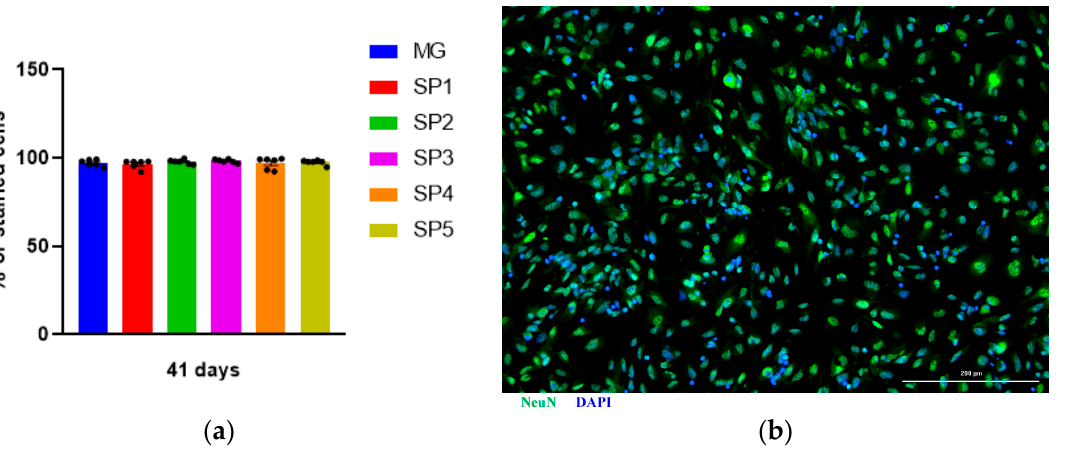
Figure 4. The effect of cultivation on CCs and MG on the differentiation of human NPCs. Immuno- cytochemical analysis of astrocyte marker S100 and neuronal marker SOX2 in human NPCs. ( a ) Percentage of S100 and SOX2 positive cells. Individual repeat values in the histogram are indicated by black dots. Mean ± SEM, N = 6. One-way ANOVA. ( b ) Immunocytochemical staining of NPCs with antibodies against S100, SOX2. Representative photographs. Scale line is 200 μ m.